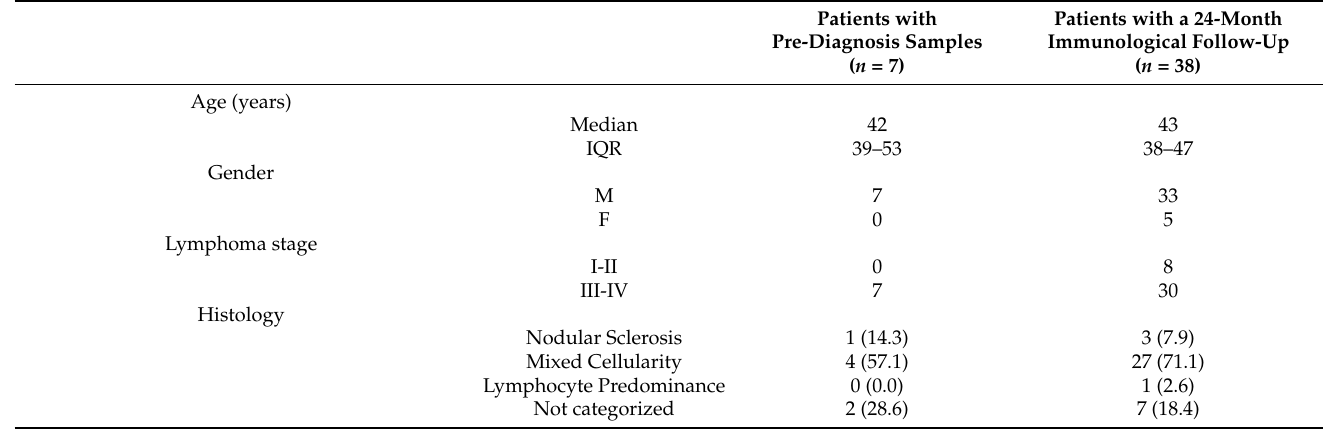
Table 1. Characteristics of the study population at cHL